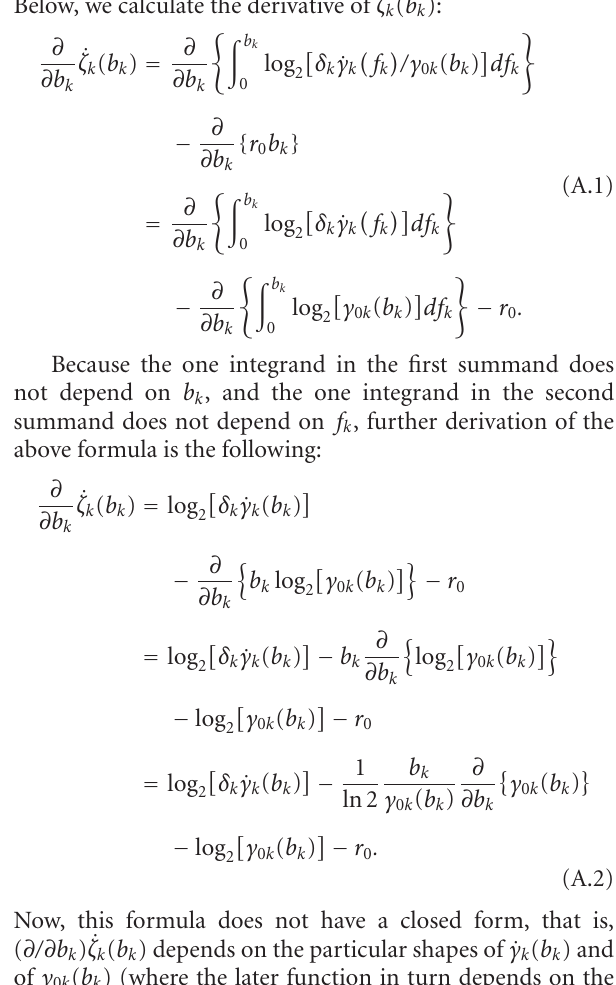
maximizing the network spectral SE 0